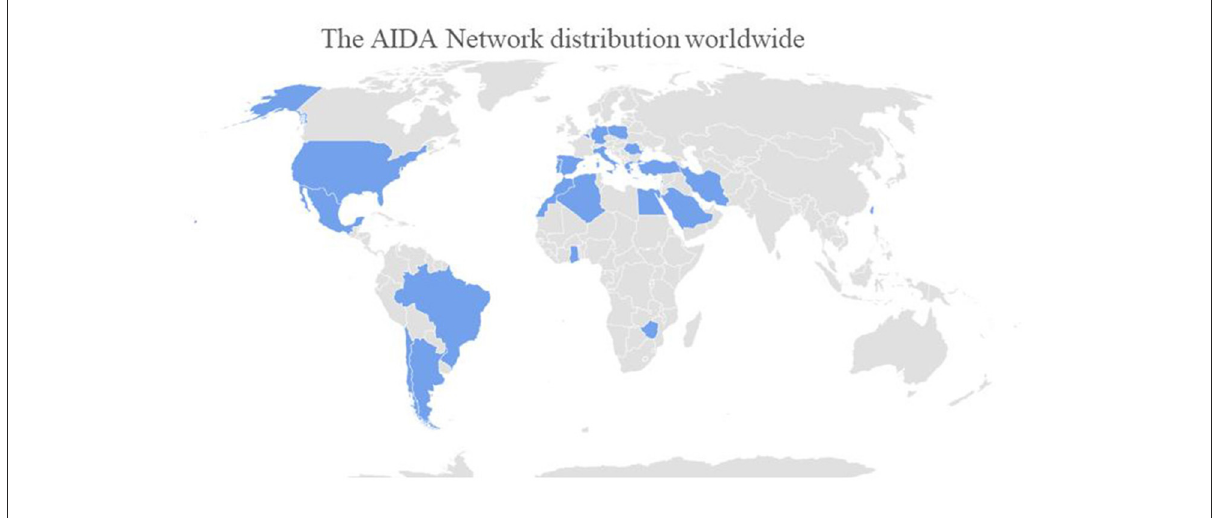
FIGURE1 Countries involved in the AIDA Network (updated on April 6 th ,